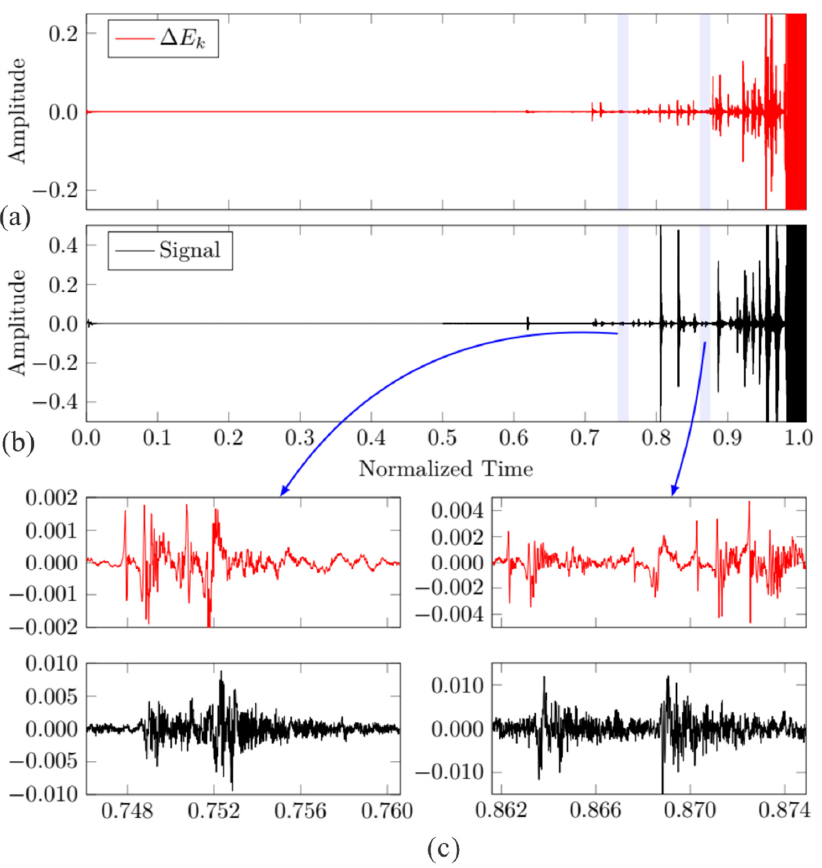
Figure 13. AE activity registered during the simulations: ( a ) using the increment of kinetic energy, ∆ E k , ( b ) with a virtual acoustic emission sensor. ( c ) Details of two typical signals for the approaches ( a , b ).